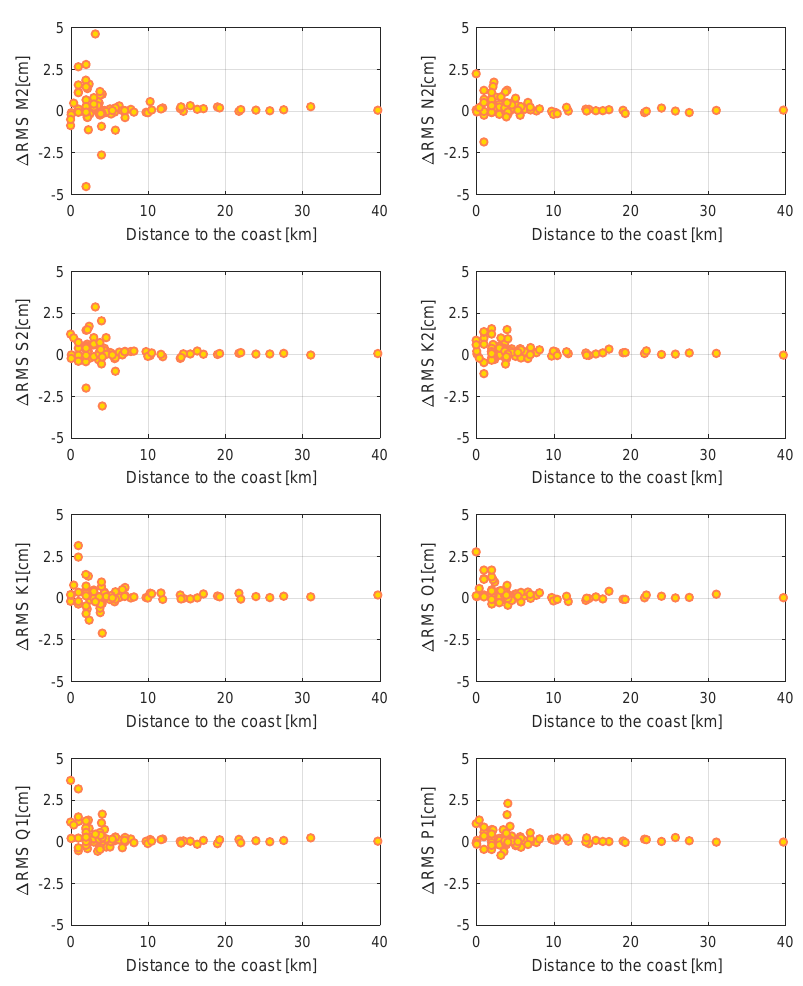
Figure 8. Absolute ∆ RMS of major constituents at the CNTG. The values are plotted against the distance to the coast (in